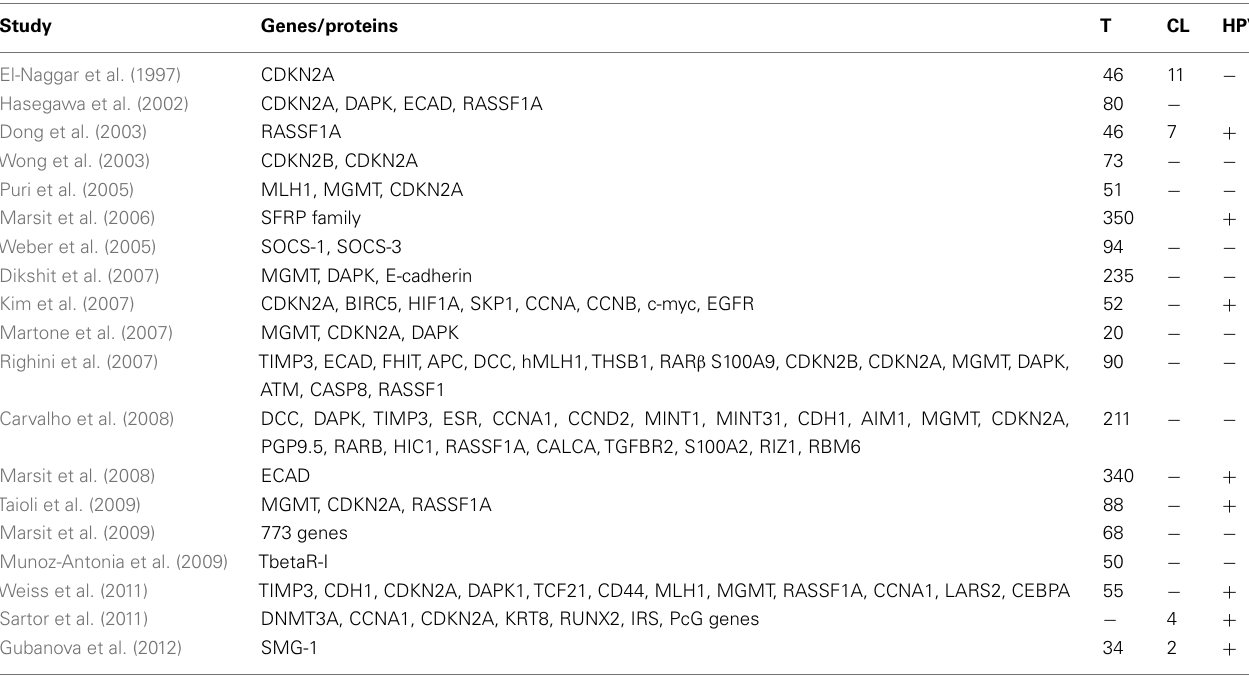
Table 2 | Summary of genes affected by DNA methylation in